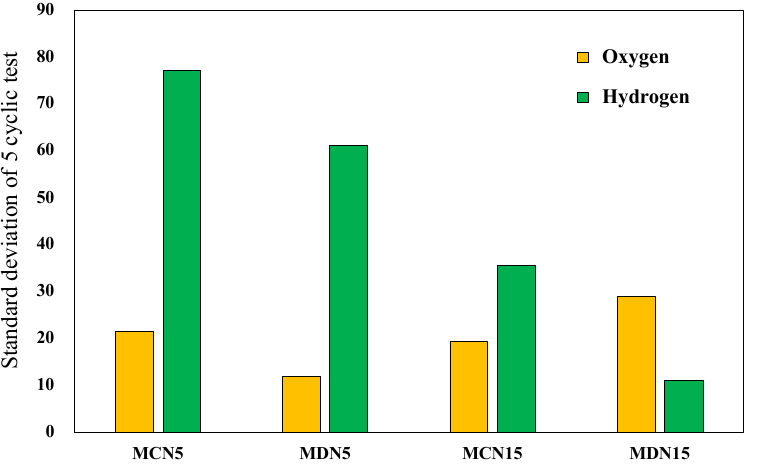
Figure 10. Standard deviation of four representative 5 and 15 mol% Mn-CeO 2 foam devices for oxygen and hydrogen.